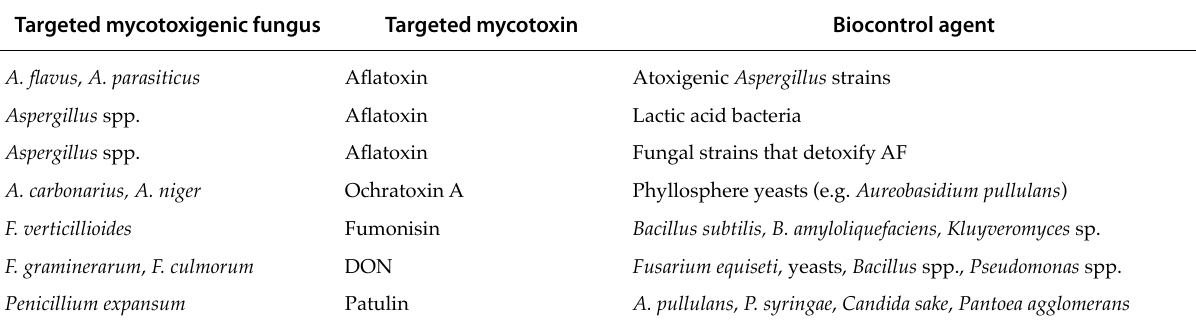
Table 1. Examples of biological agents that control mycotoxigenic fungi and mycotoxins. Targeted mycotoxigenic fungus